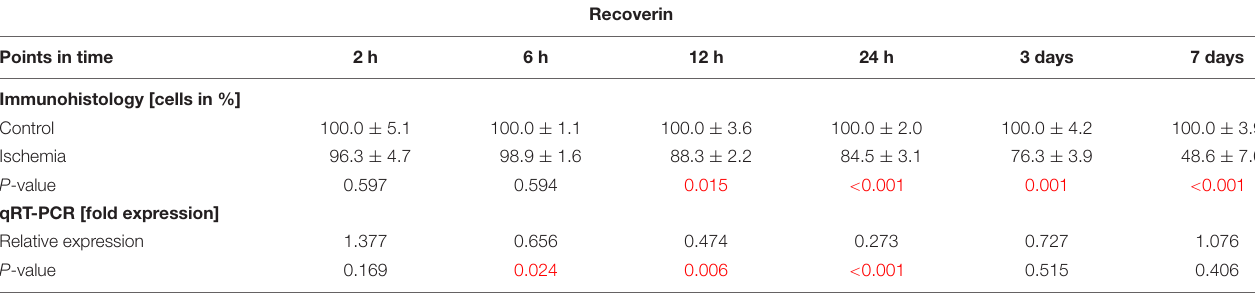
TABLE 6B | Evaluation of recoverin staining (%) as well as of expression levels of Recoverin mRNA (med) at all points in time.